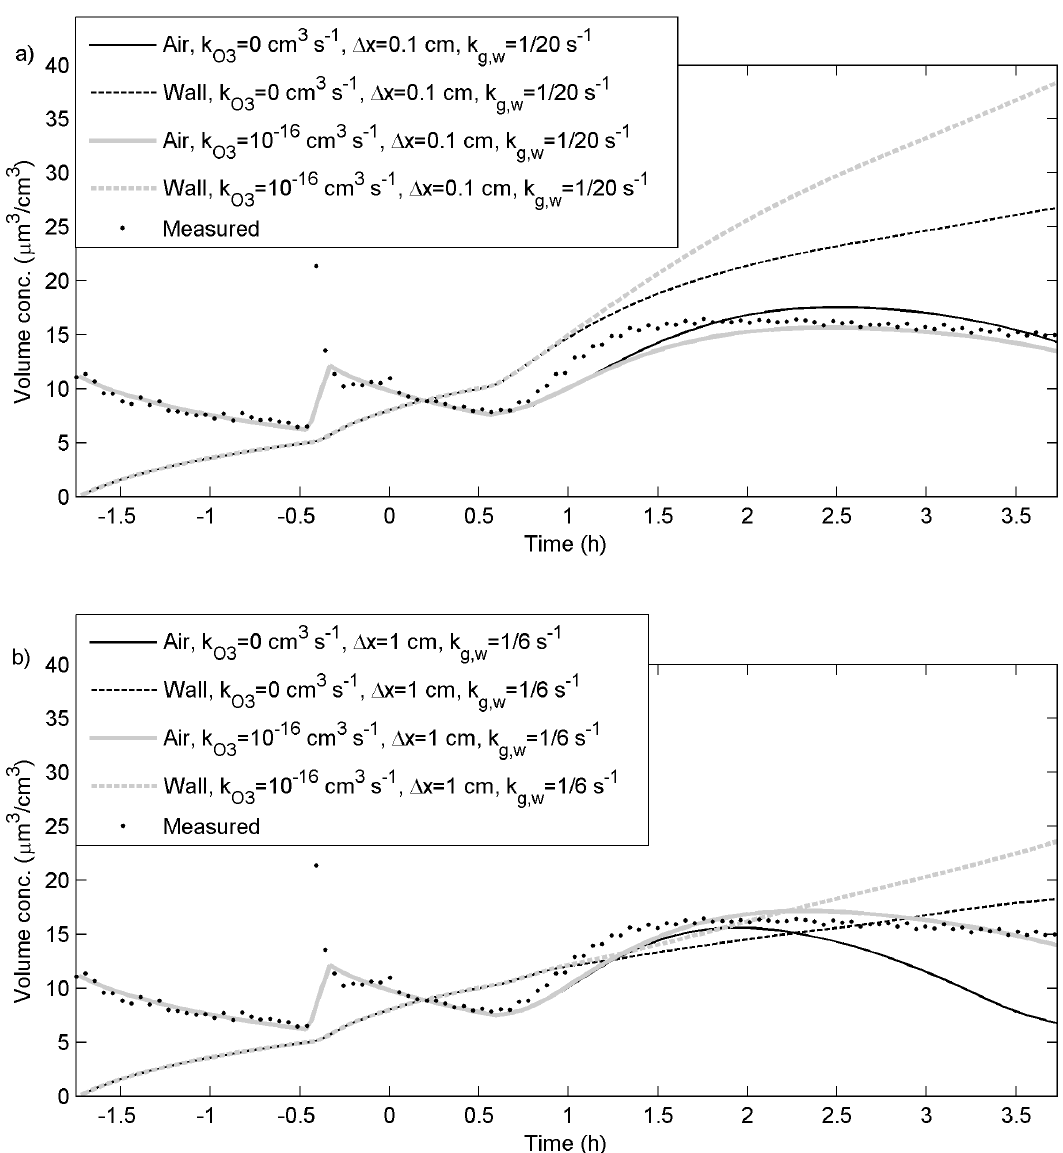
Figure 14. Modelled and measured volume concentrations of (seed aerosol + SOA coating) during the m -xylene oxidation experiment by Nordin et al. (2013). The model results are given both for the particles in the air and for those that have deposited on the chamber walls. The results in (a) are from simulations with a laminar layer width ( 1x) of 0.1cm adjacent to the chamber walls and a first-order loss rate from the near-wall gas phase to the walls ( k g , w ) of 1 / 20s − 1 . The results in (b) are from simulations with a 1x of 1.0cm and a k g , w of 1 / 6s − 1 . The figures show both the results from simulations without or with heterogeneous reactions between O 3 and unsaturated organic compounds = 10 − 16 molecules − 1 cm 3 s − 1 and D = 10 − 8 cm 2 s − 1 ) (k O 0 , O 3 3